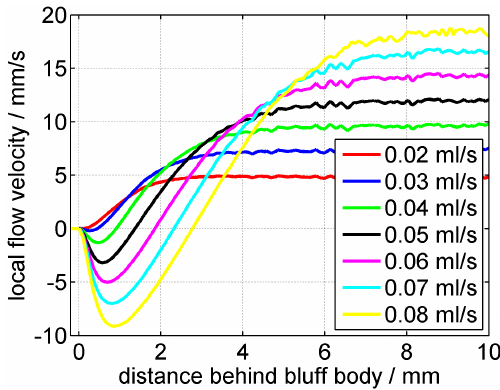
Figure 9. Simulation of local flow velocity behind the triangular bluff body along the symmetry axis for different flow rates of water.